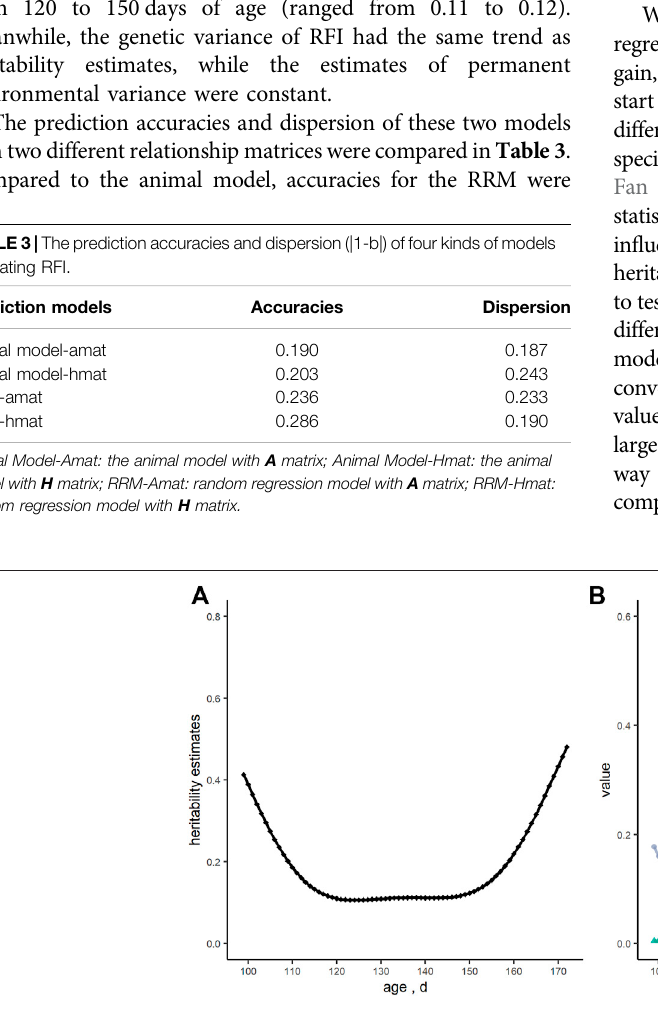
FIGURE 2 | The tendency of heritability estimates (h 2 ), genetic variance (var_a) and permanent environmental variance (var_pe) of residual feed intake (RFI, kg/d) over days in the random regression model. (A) heritability estimates; (B) genetic variance and permanent environmental variance.